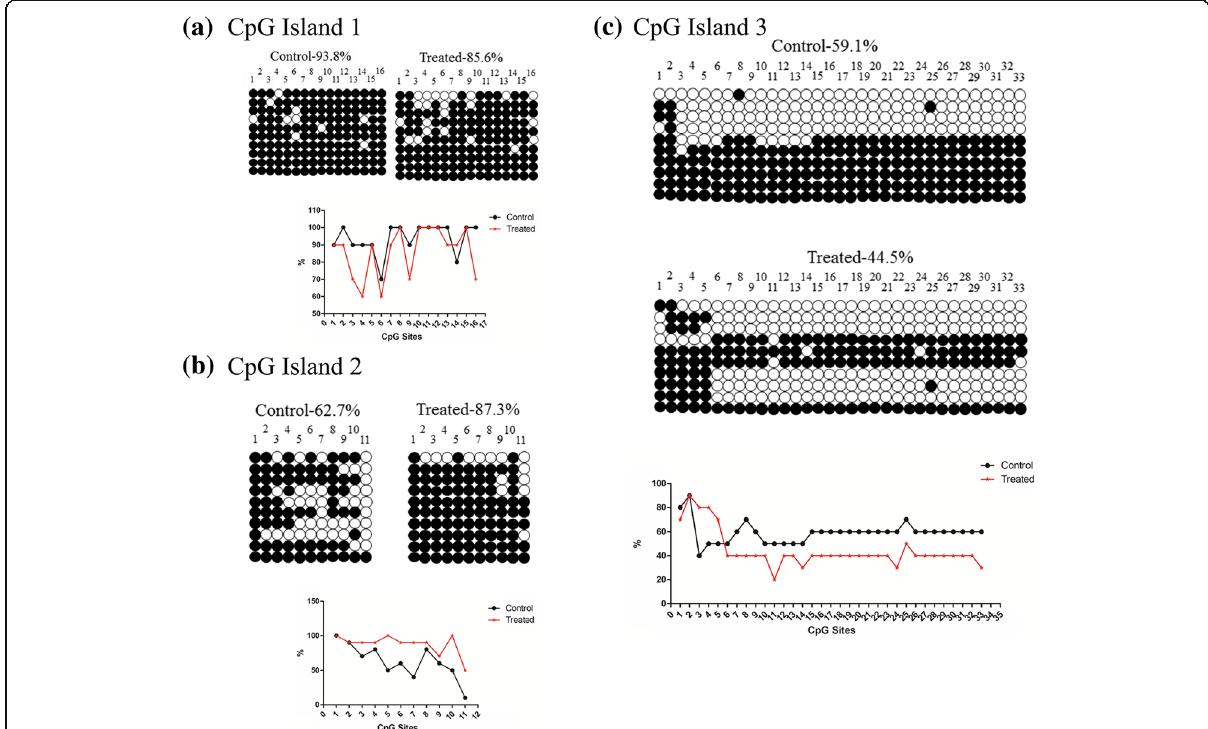
Fig. 6 The methylation of Dlk1/Dio3 DMR regions in lung. a The methylation of CpG island 1 in the control and treated tissues. b The methylation of CpG island 2 in the control and treated tissues. c The methylation of CpG island 3 in the control and treated